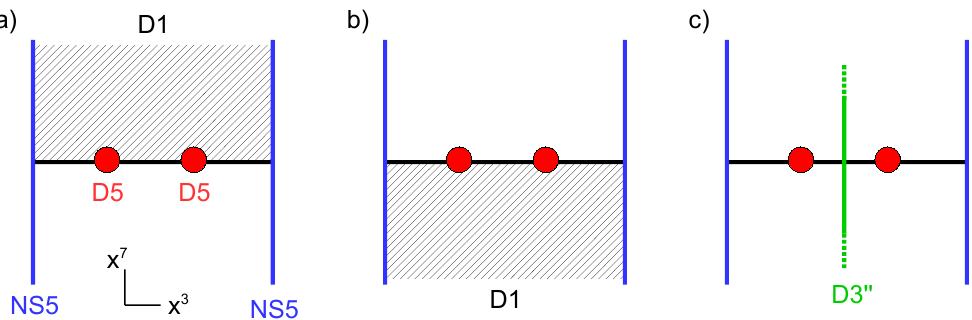
Figure 8 . a) Semi in(cid:12)nite D1 ending on the D3 from above, inserting the monopole operator u + . b) Semi in(cid:12)nite D1 ending on the D3 from below, inserting the monopole operator (cid:0) u (cid:0) . c) D3" brane crossing the D3 at an arbitrary position in x 3 between the two NS5s, inserting the scalar operator ’